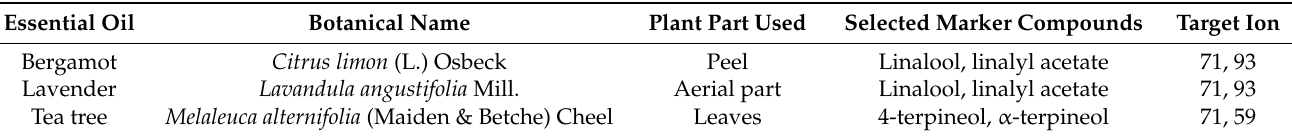
Table 6. List of the investigated EO and the selected marker compounds, together with their target ion ( m/z ), used for the